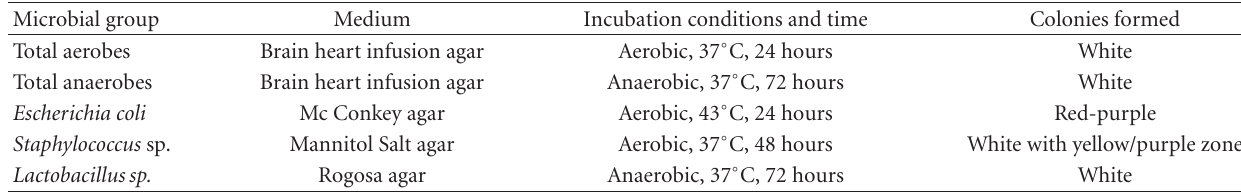
Table 2: Media and incubation conditions used for enumeration of representative microbes in the simulated human colon. Microbial group